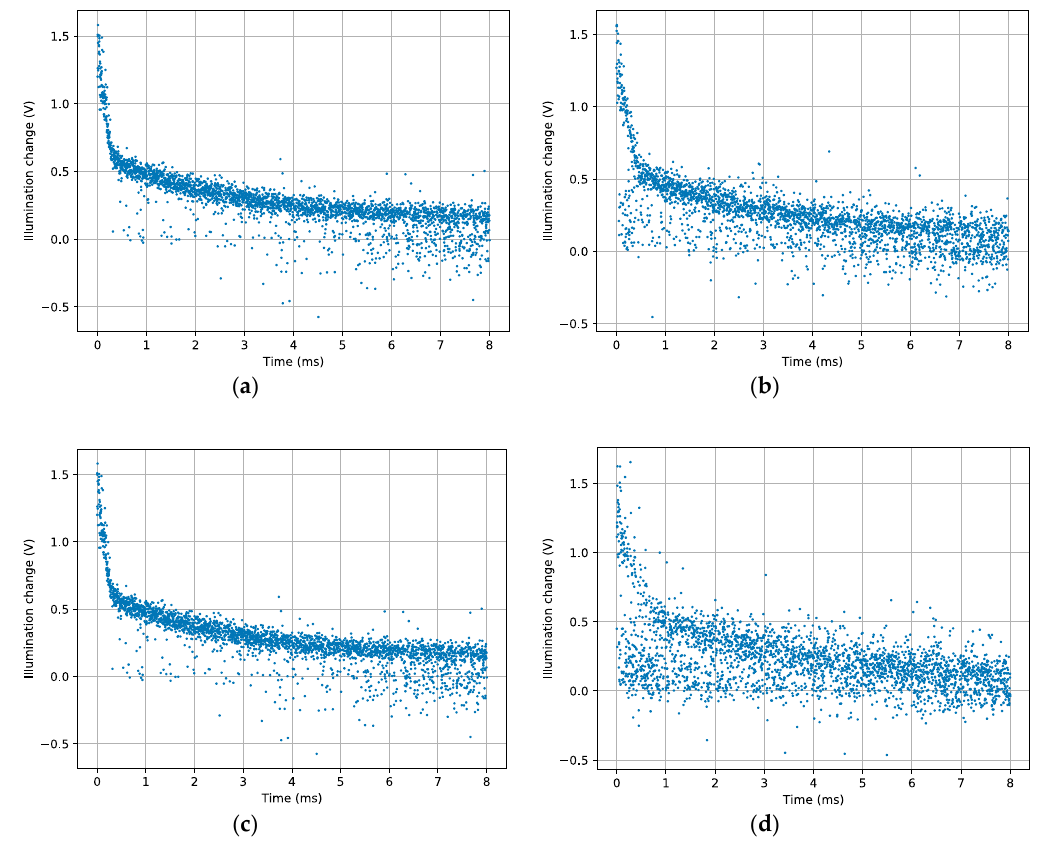
Figure 14. Illumination differences read with delays of ( a ) 0 s, ( b ) 10 s, ( c ) 20 s, and ( d ) 40 s after the event.